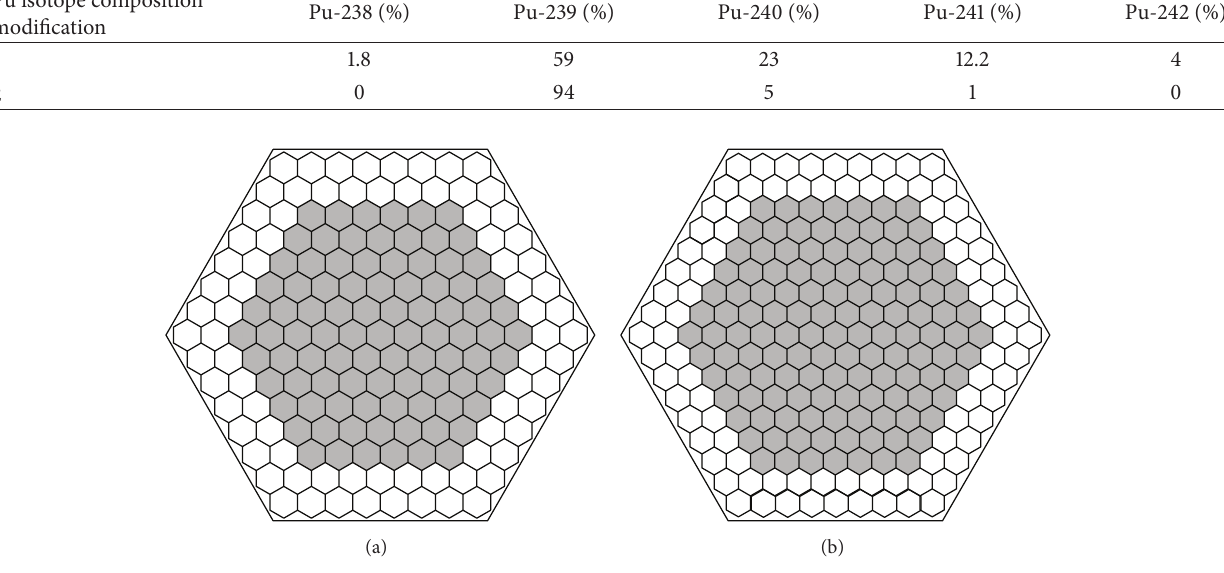
Figure 2: Calculation model of HTGTR reactor core: (a) small reactor core with the reflector; (b) large reactor core with the reflector.